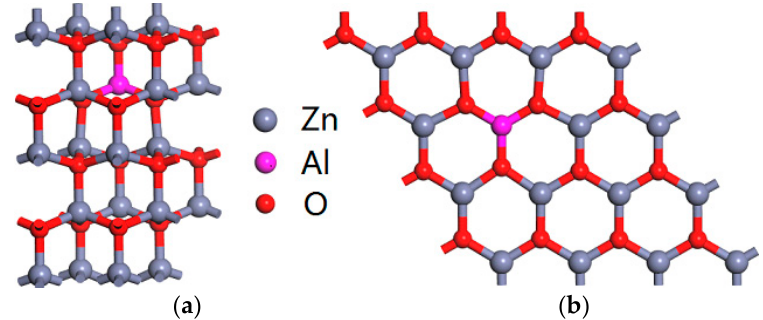
Figure 1. The structures of 6.25 at% Al-doped ( a ) bulk ZnO and ( b ) ZnO monolayer.